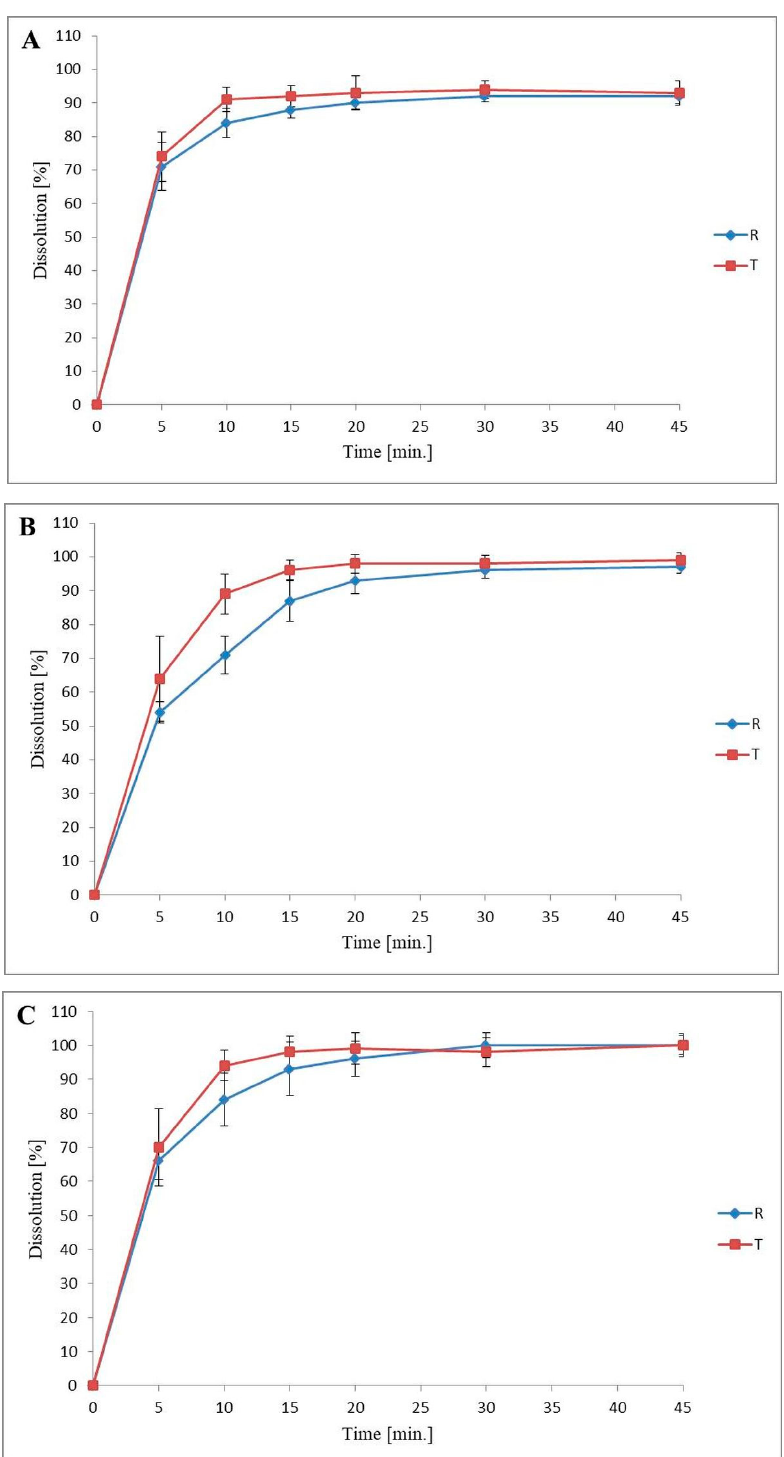
Figure 3. Comparative assessment of the in vitro release profiles of NF from in-house NF capsules (T, tested product) and Praxilene (R, reference product) in three different media 0.1 M HCl ( A ), acetate buffer ( B ), and phosphate buffer ( C ). Each time point on the curves shows the aggregated ( n = 12) average percentage of NF release level from these products.